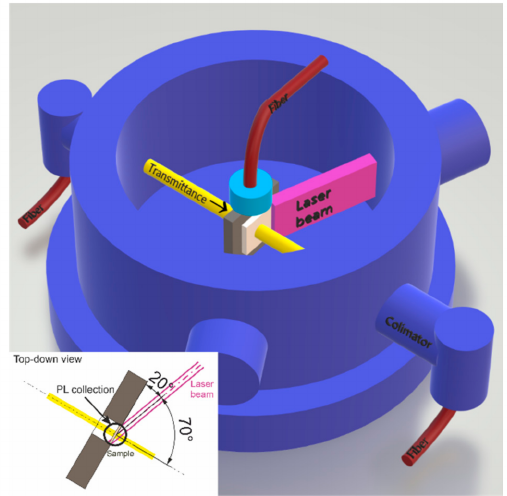
Figure 1. PLA and in situ optical properties’ measurement experimental